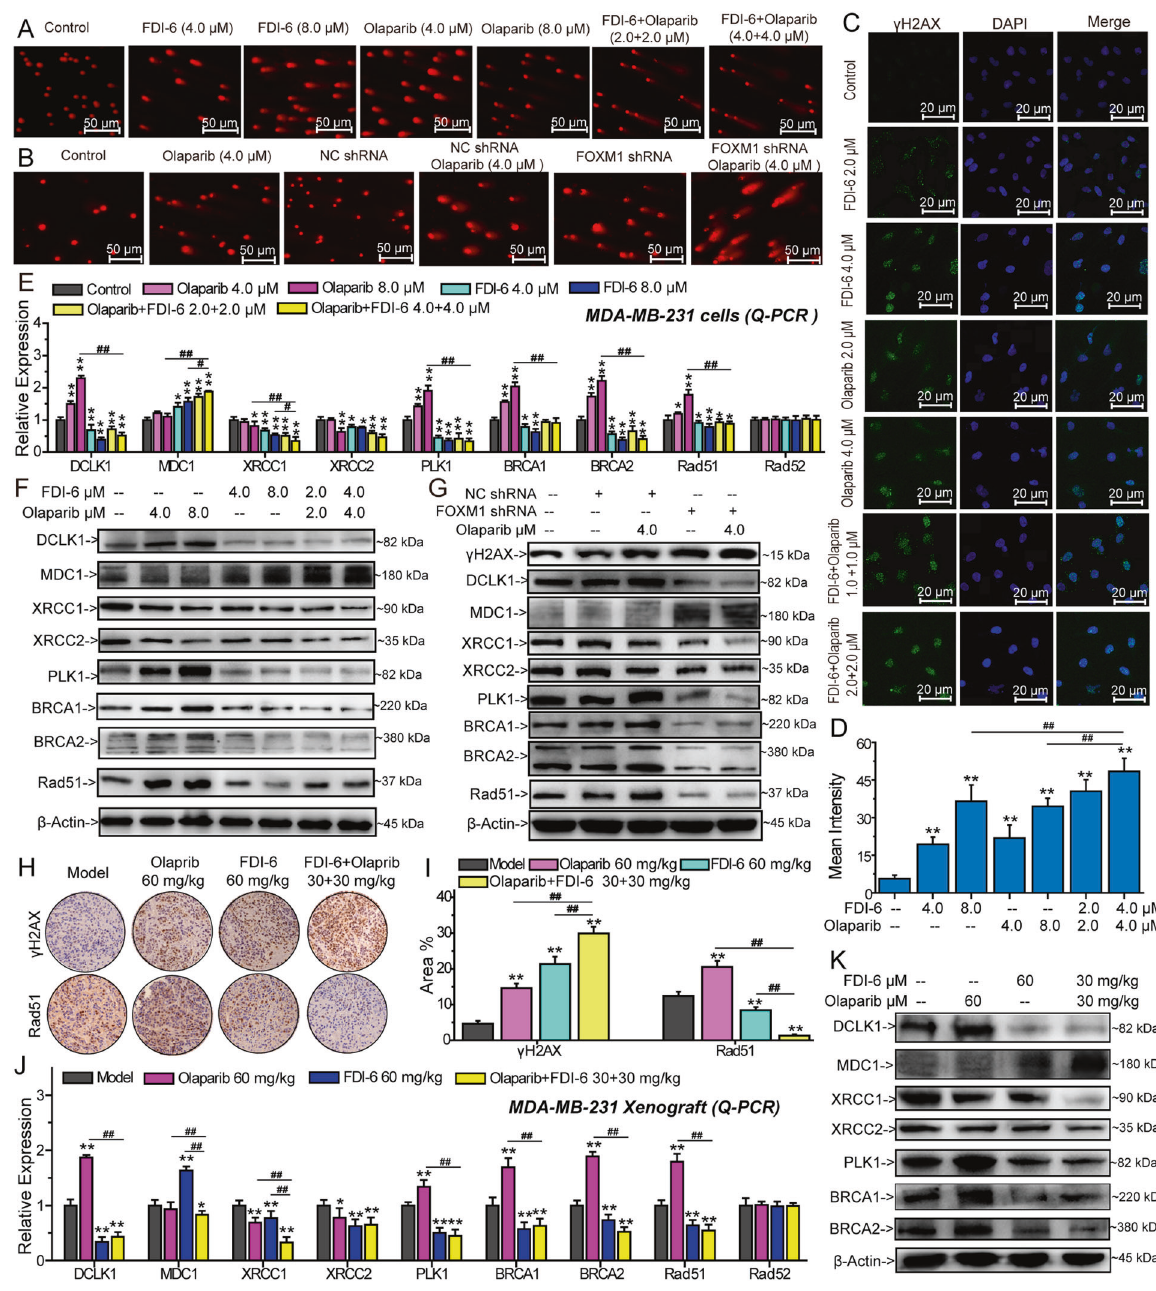
Fig. 6 The effects of FDI-6 and/or Olaparib on DNA damage and genes involved in DNA repair. A The effects of FDI-6 and/or Olaparib on DNA damage detected by alkaline comet assay. B The effects of FOXM1 shRNA and/or Olaparib on DNA damage detected by alkaline comet assay. C The expression of γ h2AX analyzed by immuno fl uorescence. Green represents the cells stained with anti- γ h2AX antibody, blue represents the nuclei stained with DAPI. D Mean intensity of immuno fl uorescence. The effects of FDI-6 and/or Olaparib on the expression of DNA repair-related factors analyzed by Q-PCR ( E ) and ( F ) in MDA-MB-231 cells. G The effects of FOXM1 shRNA and/or Olaparib on the expression of DNA repair-related proteins analyzed by Western blots. H Effects of FDI-6 and/or Olaparib on the expression of γ h2AX and Rad51 in vivo analyzed by immunohistochemistry. I Percentage of immunohistochemically stained dots. Effects of FDI-6 and/or Olaparib on the expression of factors involved in DNA repair analyzed by Q-PCR ( J ) and Western blots ( K ). The results from three independent experiments were statistically analyzed using one-way ANOVA: * P < 0.05, ** P < 0.01 compared with the control; # P < 0.05, ## P < 0.01 compared with the FDI- 6/Olaparib-combined group (FDI-6/Olaparib: 4.0 + 4.0 μ M, FDI-6/Olaparib: 30 + 30 regulates cell apoptosis and DNA repair to promote tumorigen- the ratio of 1:1 synergistically inhibited the growth of BRCA- esis [36]. Therefore, the overexpression of DCLK1 contributes to pro fi cient TNBC cells in vitro and in vivo. Further mechanistic the generation of adaptive resistance. Silencing FOXM1 studies showed that FDI-6 also inhibited the expression of expression or inhibiting FOXM1 function signi fi cantly inhibited FOXM1 and PARP1/2 to sensitize BRCA-pro fi cient TNBC cells to the expression of DCLK1 to impair Olaparib-induced DCLK1 Olaparib. DCLK1 expression was signi fi cantly promoted by expression. Olaparib. DCLK1 is a microtubule-associated oncoprotein that